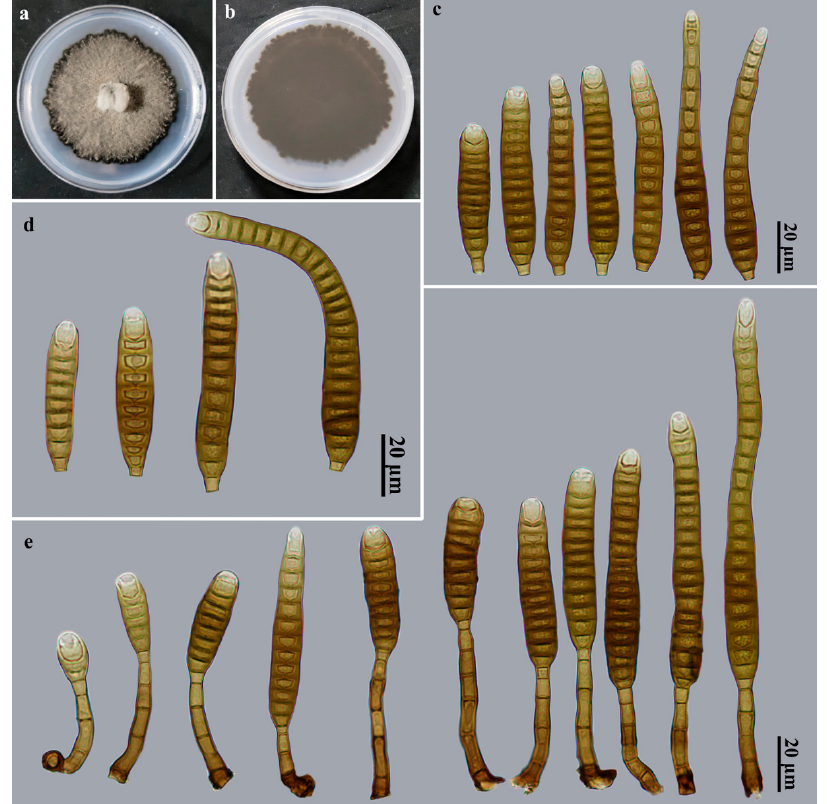
Figure 4. Distoseptispora sinensis (HJAUP M2044, holotype). ( a ) Surface of colony after 2 weeks on PDA; ( b ) reverse of colony after 2 weeks on PDA; ( c , d ) Conidia; ( e ) Conidiophores, conidiogenous cells, and conidia.